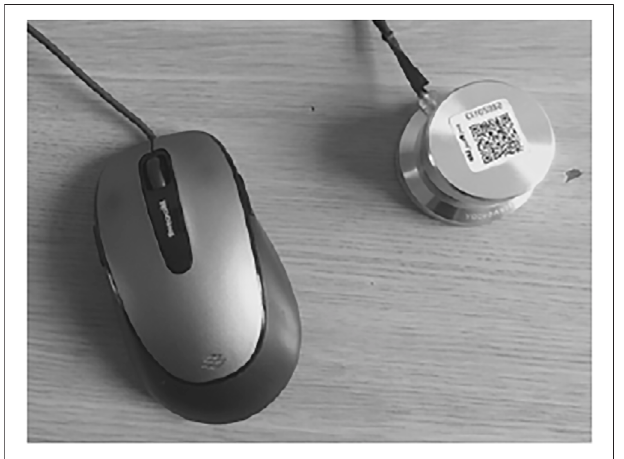
FIGURE 2 | left is mouse, right is